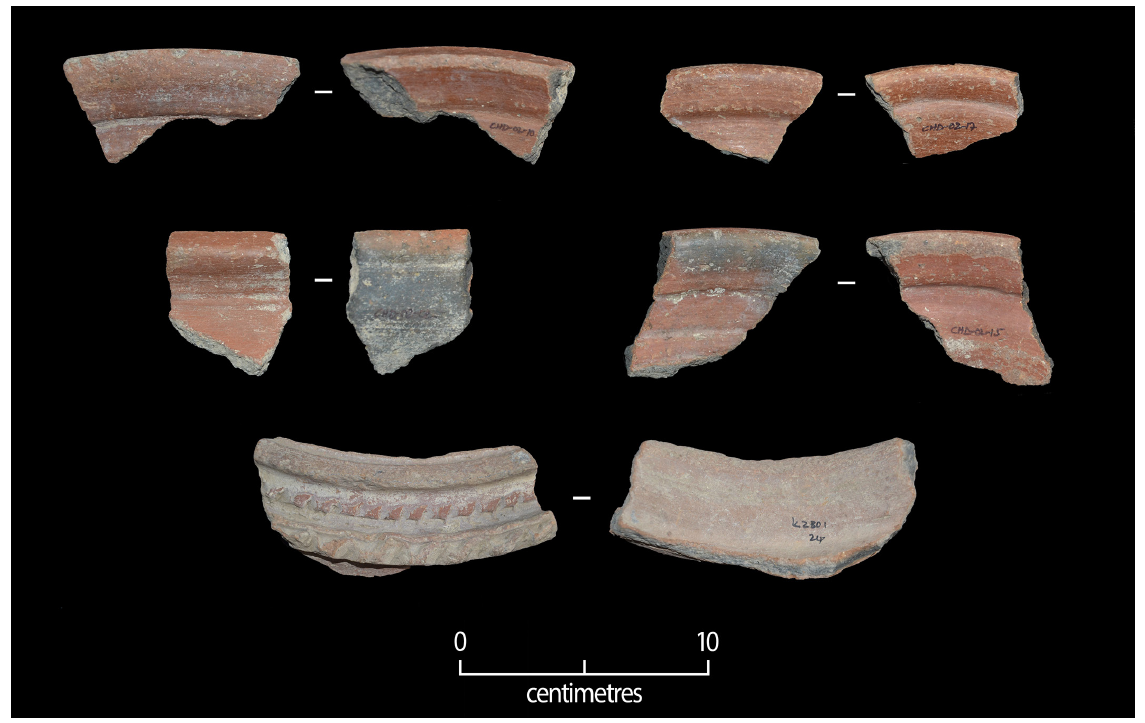
Figure 37: External and internal surfaces of Class 14 variant 1 potsherds.